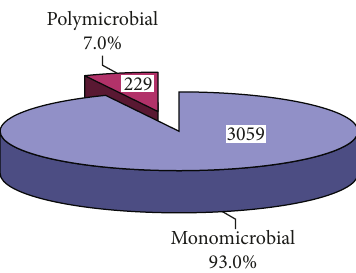
Monomicrobial Figure 3: Pattern of contamination among different hospitals (2009–2015) in Assiut city.